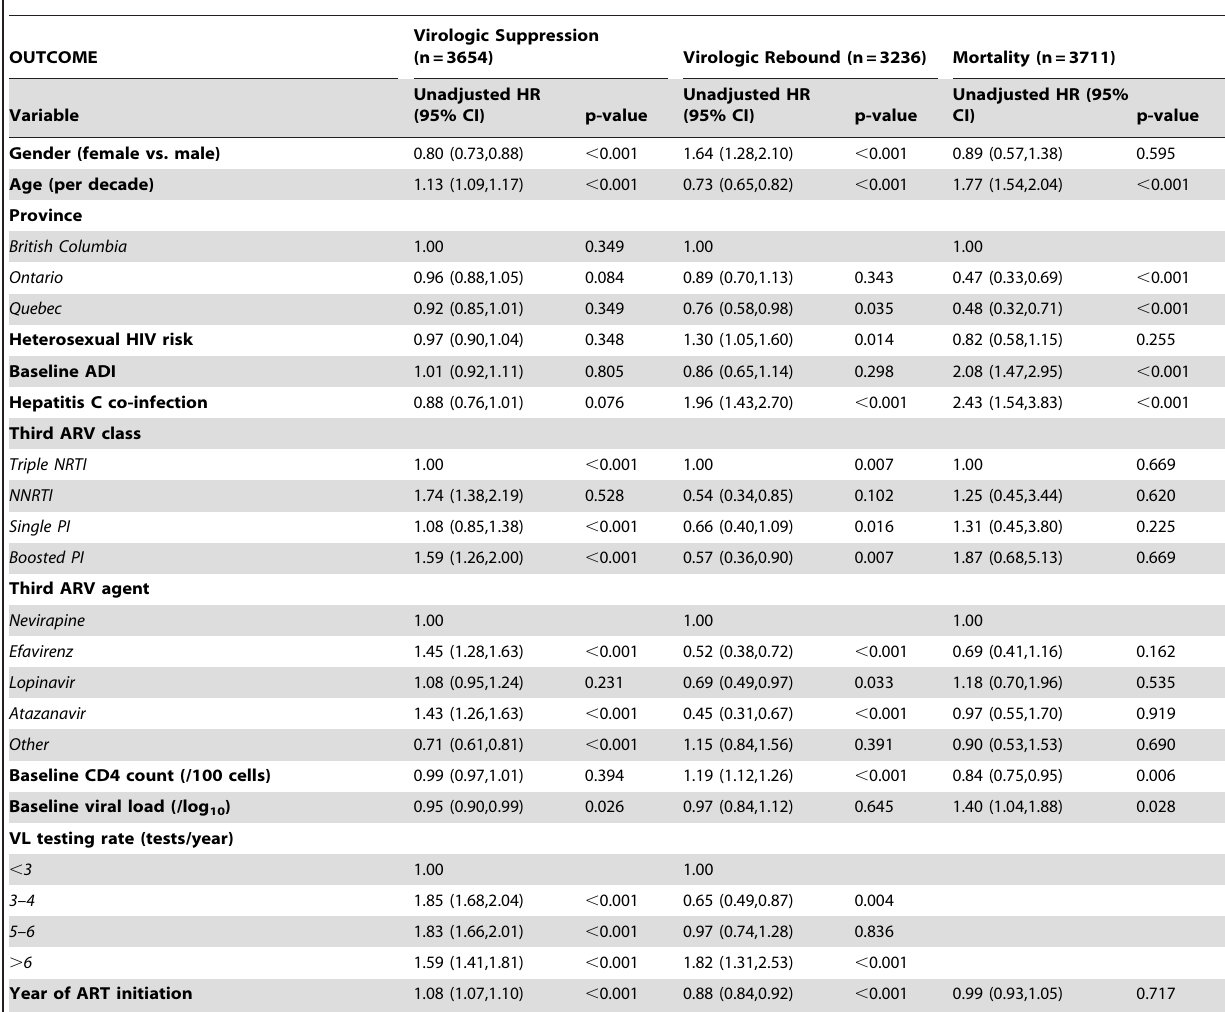
Table 4. Unadjusted analyses exploring gender differences in clinical outcomes among individuals without IDU